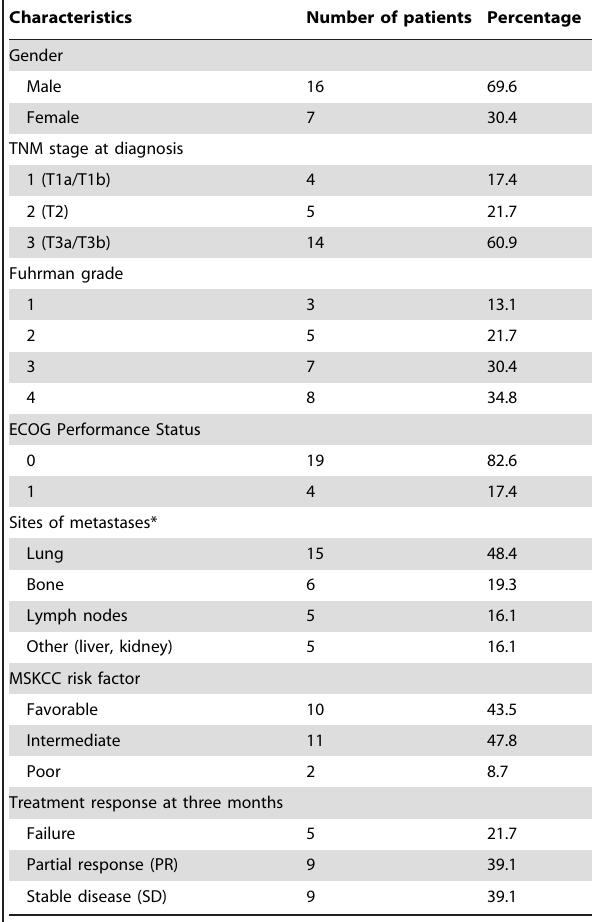
Table 1. Patient